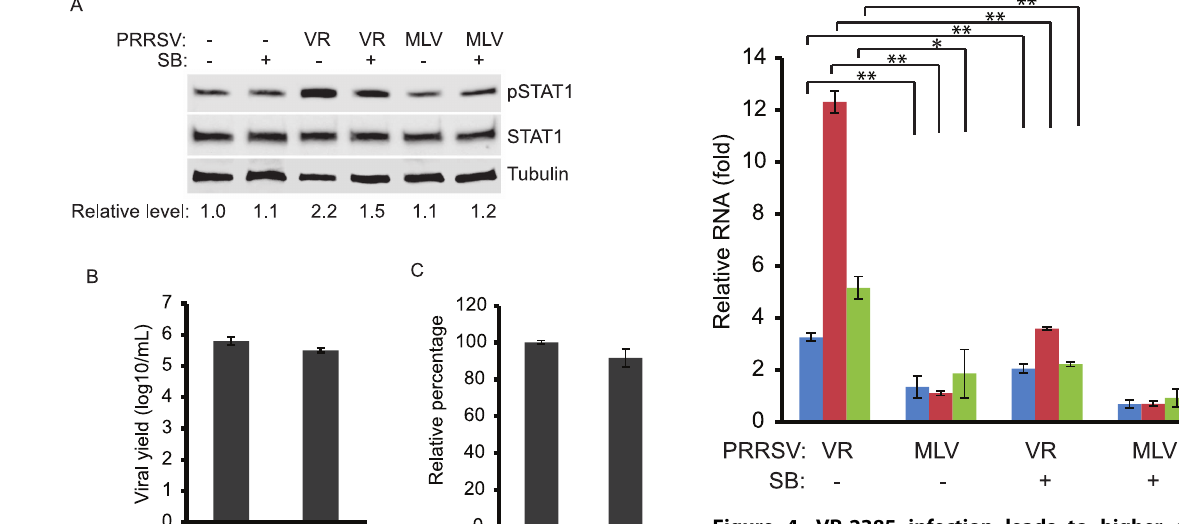
Figure 4. VR-2385 infection leads to higher expression of proinflammatory cytokine genes than MLV and SB203580 treatment reduces their expression. MARC-145 cells were infected with VR-2385 or MLV and treated with SB203580. Mock-treated cells were included for control. The cells were harvested at 48 hpi for RNA isolation and RT-qPCR. Relative folds of transcript levels of IL-1 b , IL-8, and ISG54 in comparison with mock-treated PRRSV-negative cells are shown. Error bars represent variation of three repeated experiments. Significant differences between paired samples are shown by ‘‘*’’ and ‘‘**’’, which indicate P , 0.05 and P , 0.01, respectively.